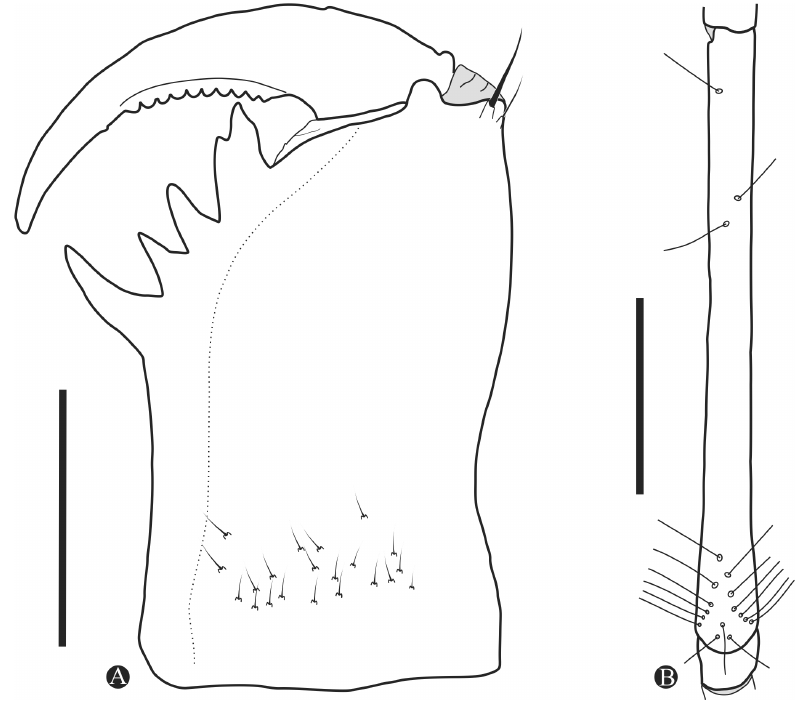
Figure 2. Chelicerae ( A ) and distitibia of leg IV ( B ) of Charinus ruschii sp. n. (MNRJ 9237 and MNRJ 9235, respectively). Scale bars: 1